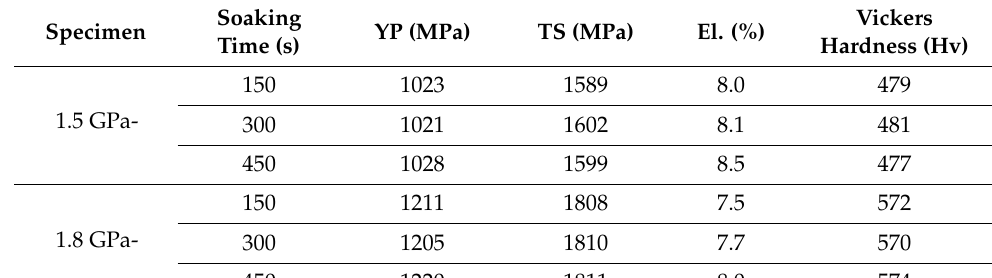
Figure 2. SEM images of martensitic phase: ( a ) the 1.5 GPa grade steel austenitized for 150 s at 1203 K and ( b ) the 1.8 GPa grade steel austenitized for 150 s at 1203 K. Table 3. The values of parameter from strain–stress curves.